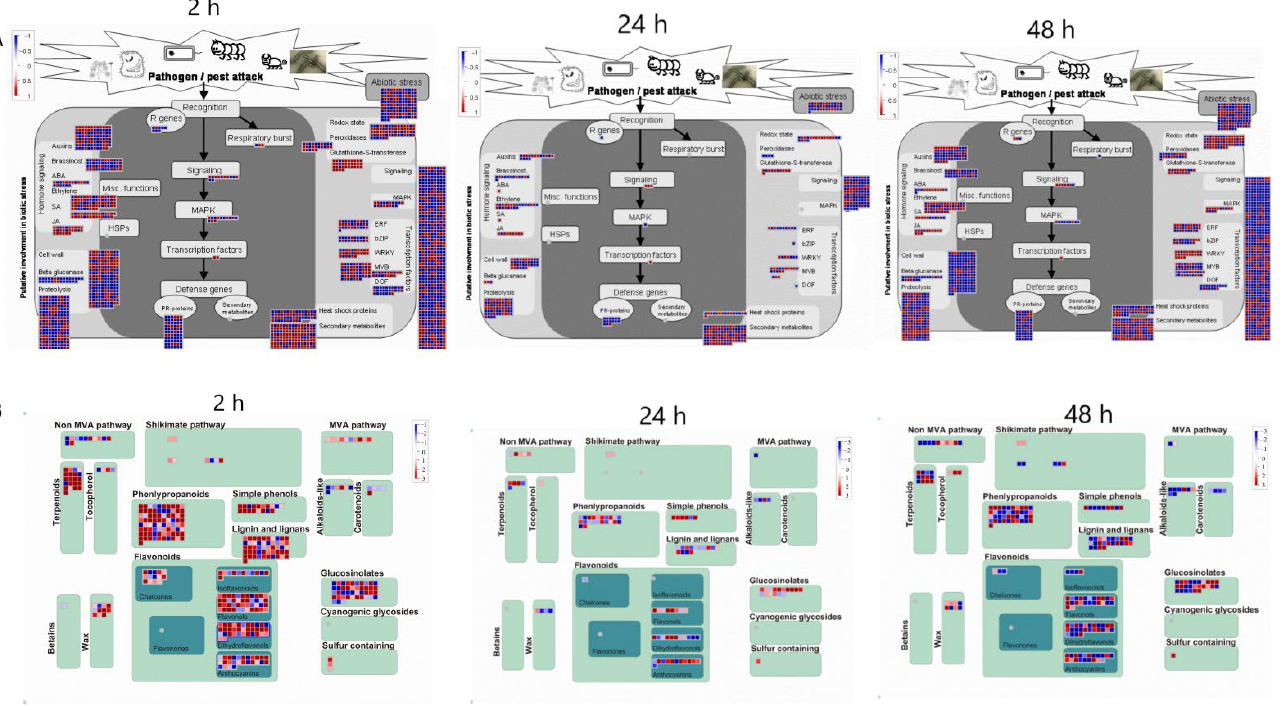
Figure 5. MapMan analysis of differentially expressed genes of C. vietnamensis in response to MeJA. ( A ): CK vs. 10 mM MeJA differentially expressed genes associated with stress response. ( B ): CK vs. 10 mM MeJA differentially expressed genes associated with secondary metabolism.